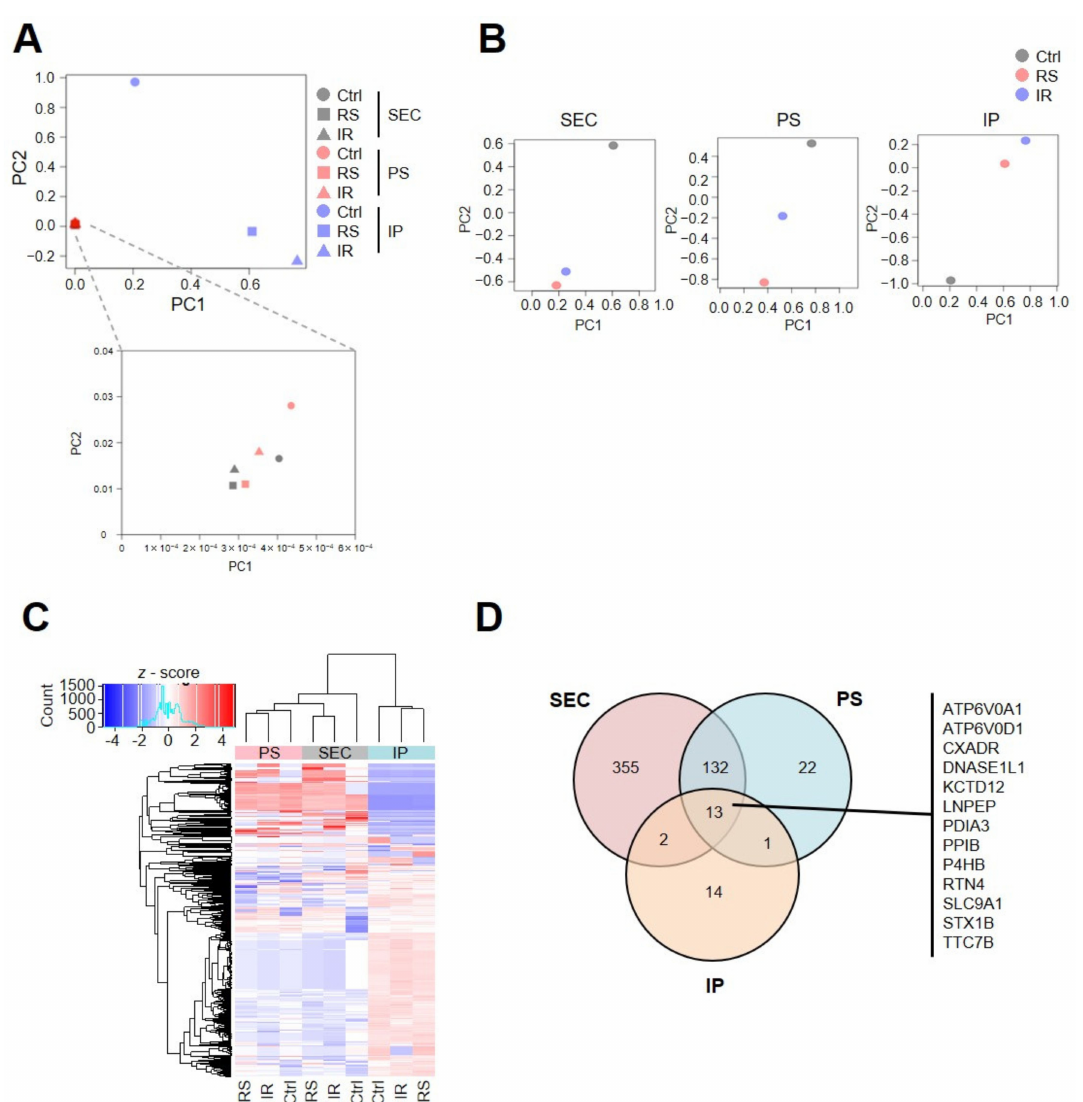
Figure 2. Proteomic characterization of smallEVs. ( A ) Principal component analysis (PCA) performed with the prcomp function using the log10 abundances calculated by mass spectrometry analysis of sEVs in Figure 1E. PCA was performed on all samples ( A ) or each collection method ( B ), as shown. In the lower panel of Figure 2A, the enlarged figure is shown in SEC and PS. ( C ) Heatmap corresponding to proteins detected by mass spectrometry analysis of sEVs in Figure 1E. Each column shows the values normalized to the z-score. ( D ) For each collection method, proteins with an abundance ratio of RS-EVs to Ctrl-EVs and IR-EVs to Ctrl-EVs that were more than twice were extracted. Among them, thirteen proteins were common in sEVs collected by the three